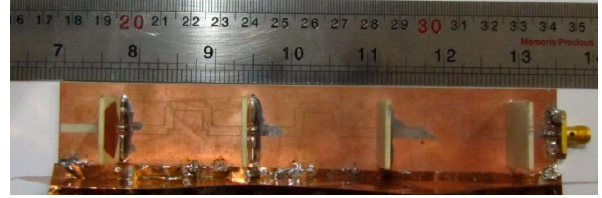
Figure 4. Fabricated fan beam array antenna.